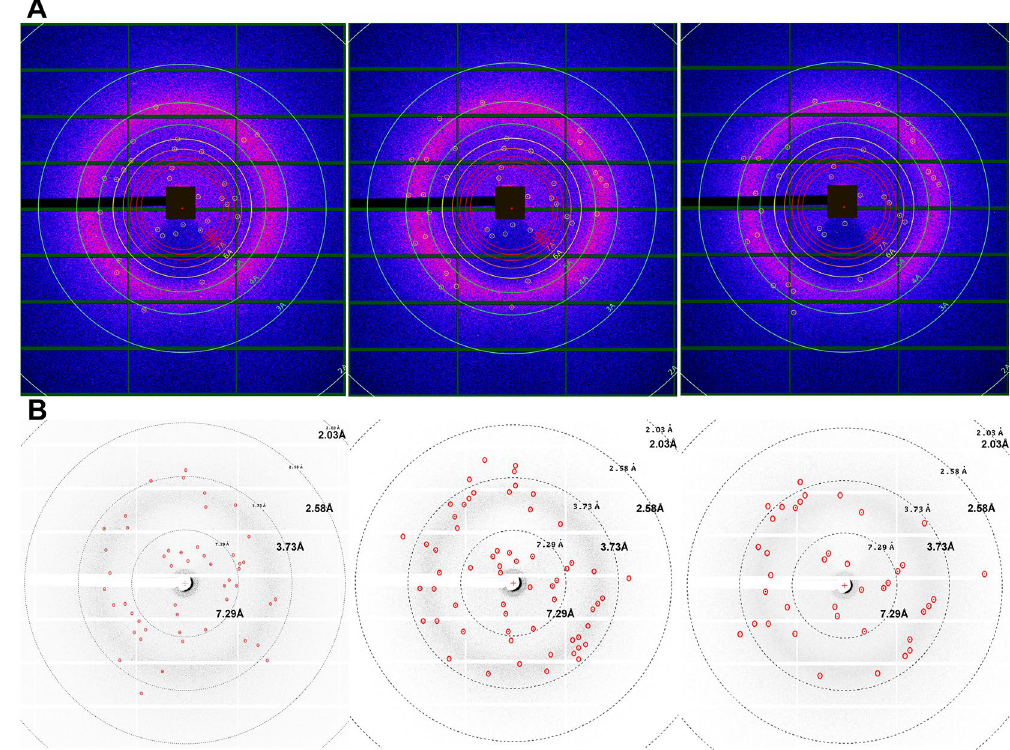
Figure 6. Indexed diffraction patterns from pGC-A microcrystals collected via serial crystallography at the Advanced Photon Source. Three indexable diffraction patterns with the highest resolution of 3 Å. ( A ) Blue/ pink diffraction graphs show diffraction patterns analyzed using CrystFEL software. ( B ) The original diffraction patterns shown with white background. All diffraction dots were manually circled in red for better